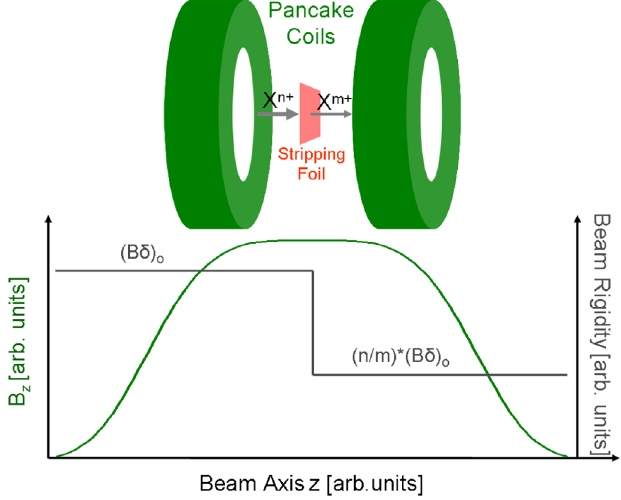
FIG. 6. Conceptual layout of an ion stripper setup providing a nonsymplectic transformation M ns for later transverse emittance transfer. The stripping foil is placed between two pancake coils, i.e., inside a region with a longitudinal magnetic field of few Tesla in strength.